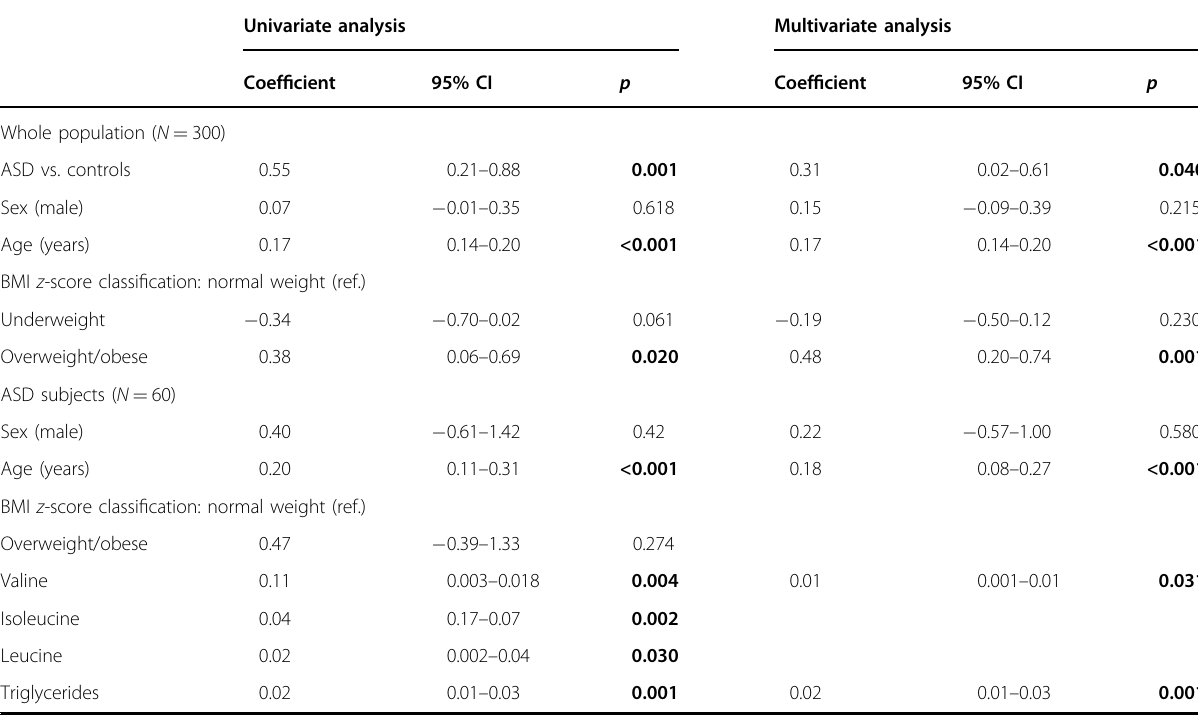
Table 3 Predictors of HOMA-IR. Univariate analysis Multivariate